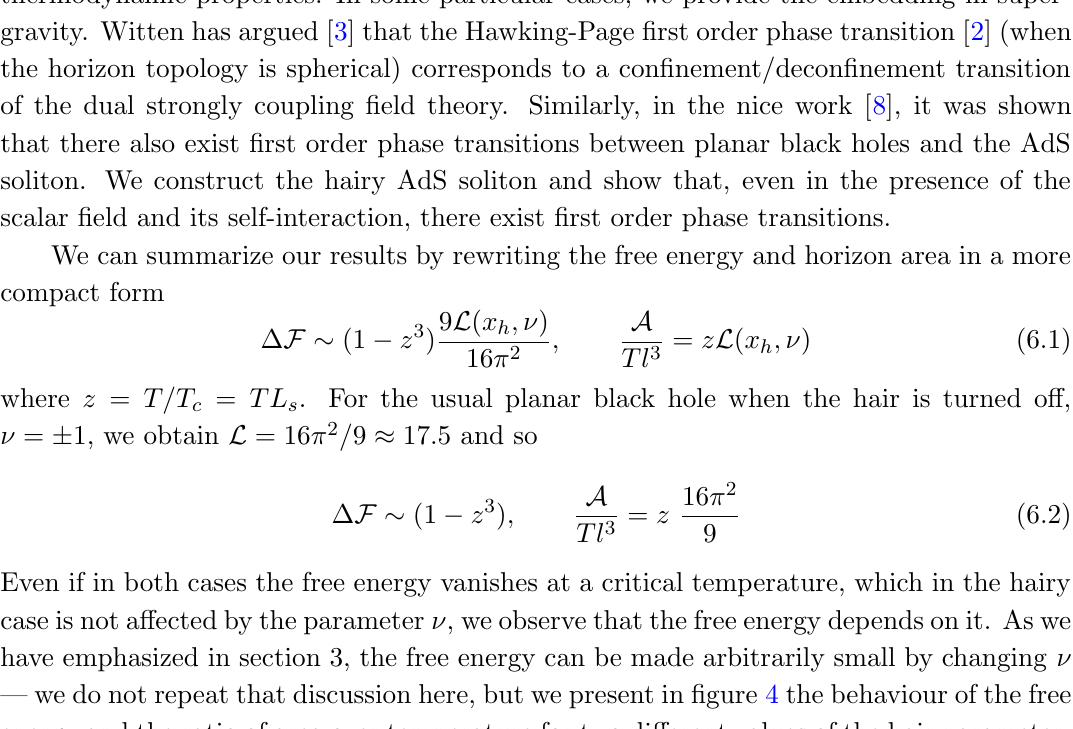
Figure 4 . The continuous lines represent the case (cid:23) = 1. We observe that, by increasing (cid:23) , the free energy is decreasing. When z < 1, in the hairy case we have A < Tl 3 for z < 1 This means that even if the small hairy black holes can be colder than the planar black hole without hair for which z < 0 : 06, the hairy AdS soliton is still the preferred